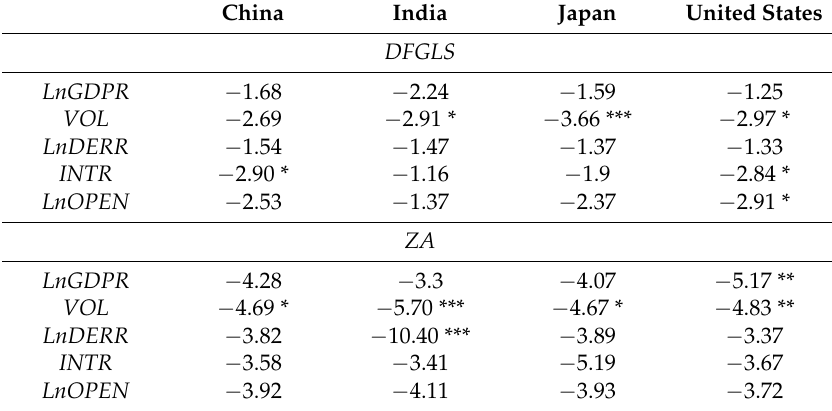
Table 4. Results of unit-root